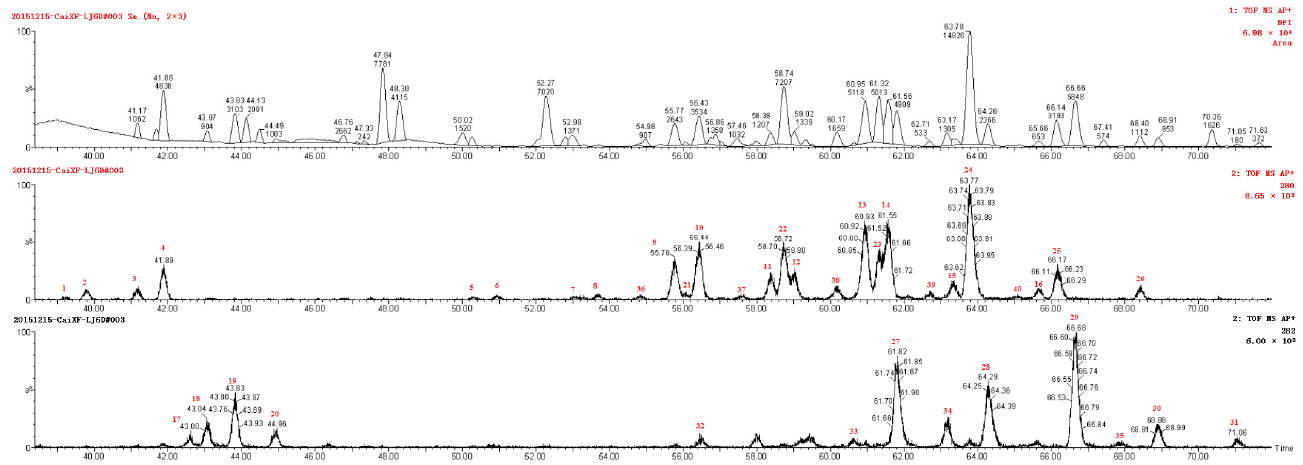
Figure 1. Chromatograms of UHPLC-Q-TOF/MS and compounds contain m / z = 280, 282 fragment ion peaks.